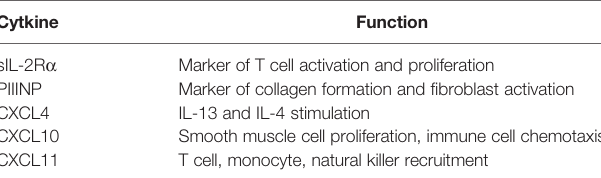
TABLE 2 | Taxa Cytokines observed to be predictors of SSc development. Cytkine